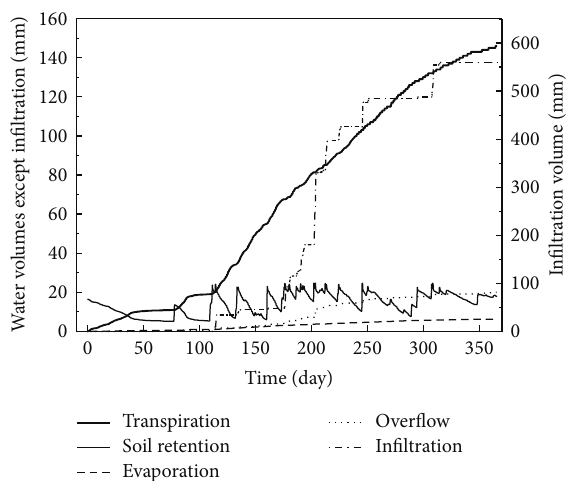
Figure 9: Accumulative water volumes variation with time in the long-term simulation using the annual meteorological data in 2012.